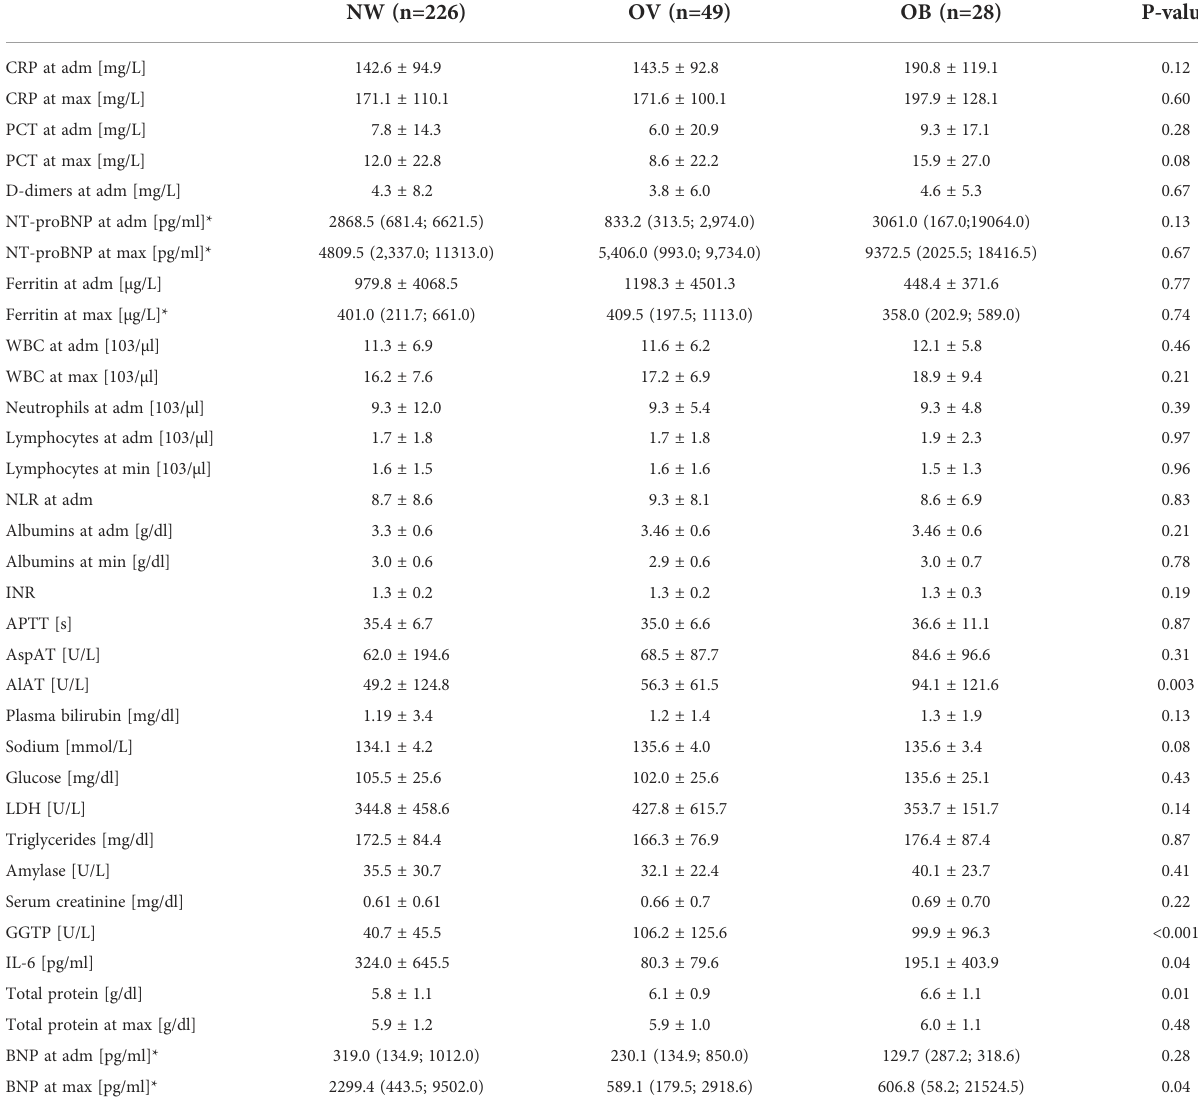
TABLE 5 Comparison of laboratory results between the NW, OV, and OB groups at